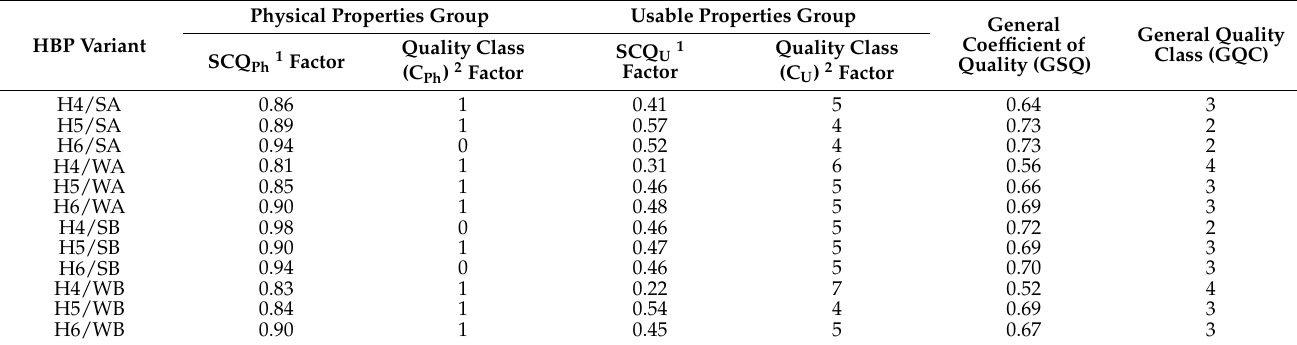
Table 8. Selection of the optimal three-components HBP.